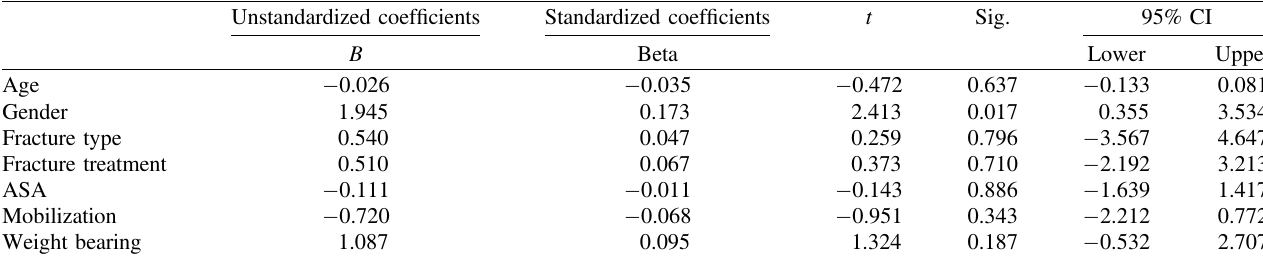
Table 8. Predictors for length of stay (in days).